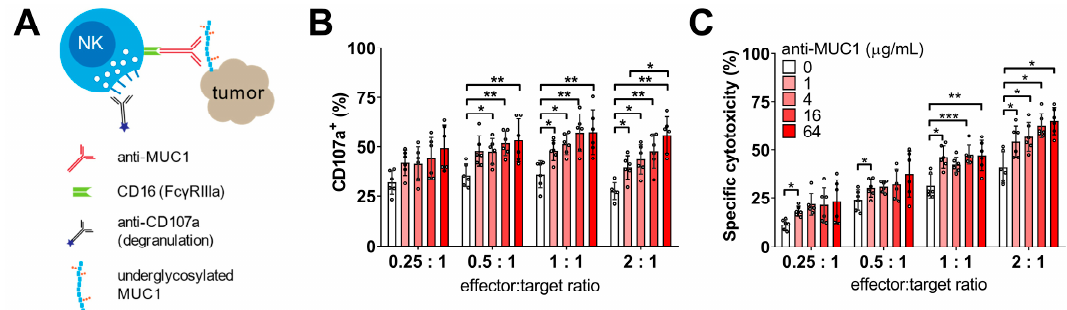
Figure 4. Increasing concentrations of humanized anti-MUC1 antibodies do not further enhance NK cell degranulation and cytotoxicity. ( A ) Experimental overview of the analysis of degranulation and cytotoxicity after co-culture of human NK cells with Jurkat MUC-Tn positive tumor cells in the presence of anti-MUC1 antibodies. ( B ) Fraction of degranulation NK cells after 4 h of co-culture with different effector/tumor ratios and antibody concentrations. ( C ) Quantification of antibody-dependent cellular cytotoxicity at different E:T ratios and antibody concentrations. Bars indicate mean ± SD, and dots are individual NK cell donors from independent experiments ( n = 6 per experimental group). Statistical analysis using two-way ANOVA plus Tukey’s multiple comparisons test. p < 0.05 (*); p < 0.01 (**); p < 0.001 (***).